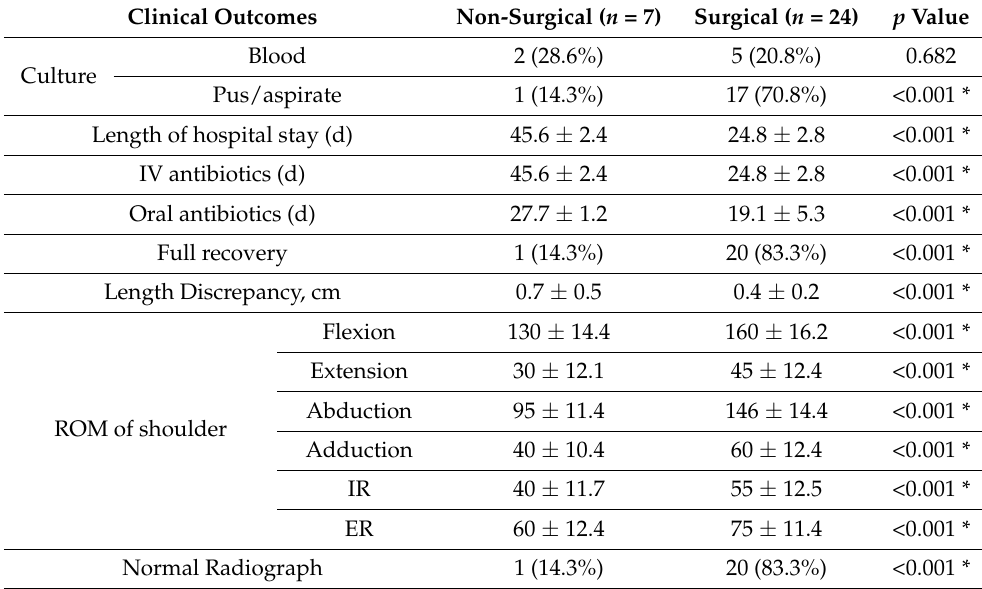
Table 2. Clinical outcome of the patients.